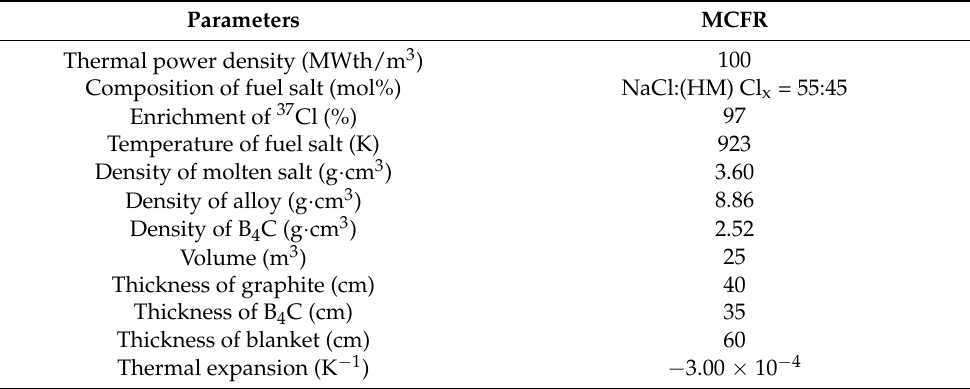
Table 1. Parameters of the optimized MCFR.